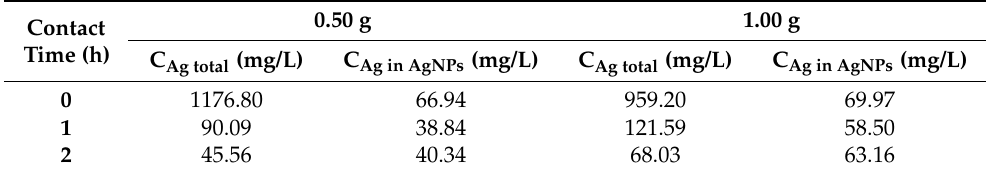
Table 2. Preliminary results for AgNPs purification with the resin Dowex 50W-X8 50–100 mesh, for resin masses of 0.50 and 1.00